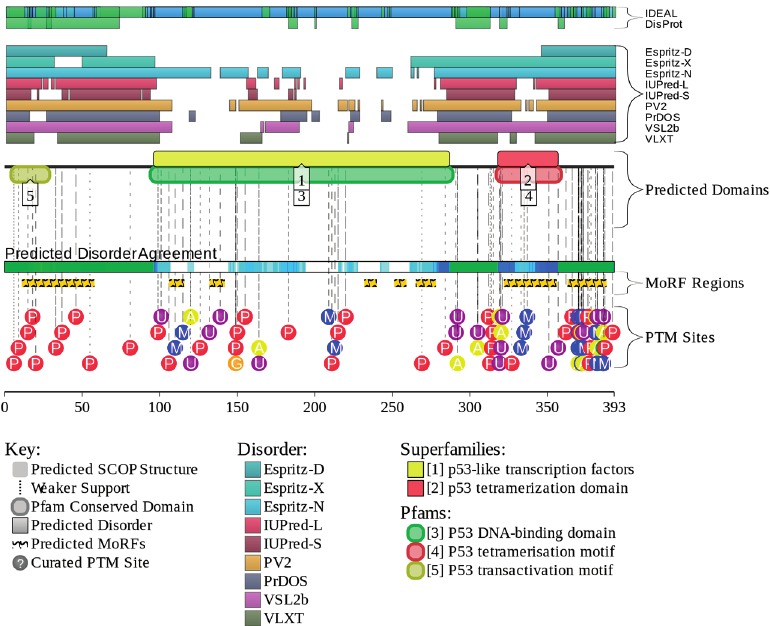
Figure 6. Evaluation of the functional intrinsic disorder propensity of human p53 (UniProt ID: P04637) by D 2 P 2 database (http://d2p2.pro/) [71]. In this plot, top two lines represent